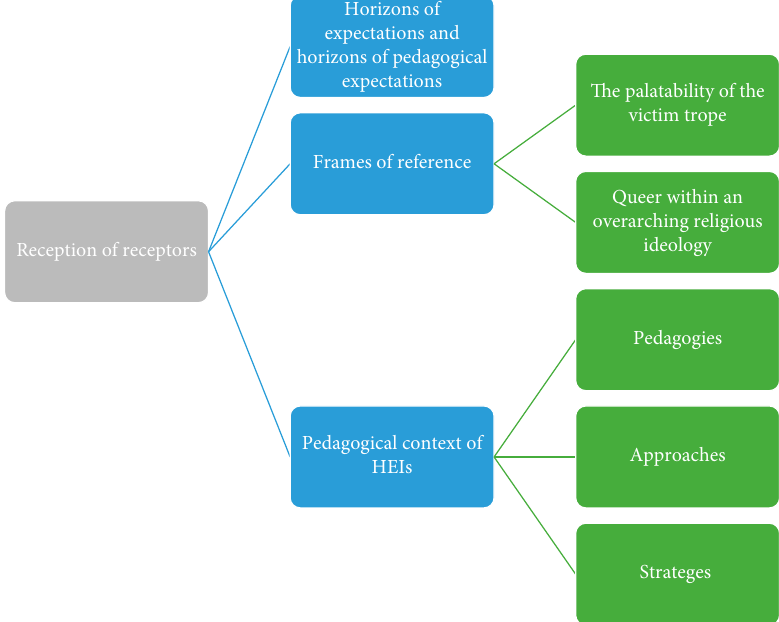
Figure 1: Conceptual